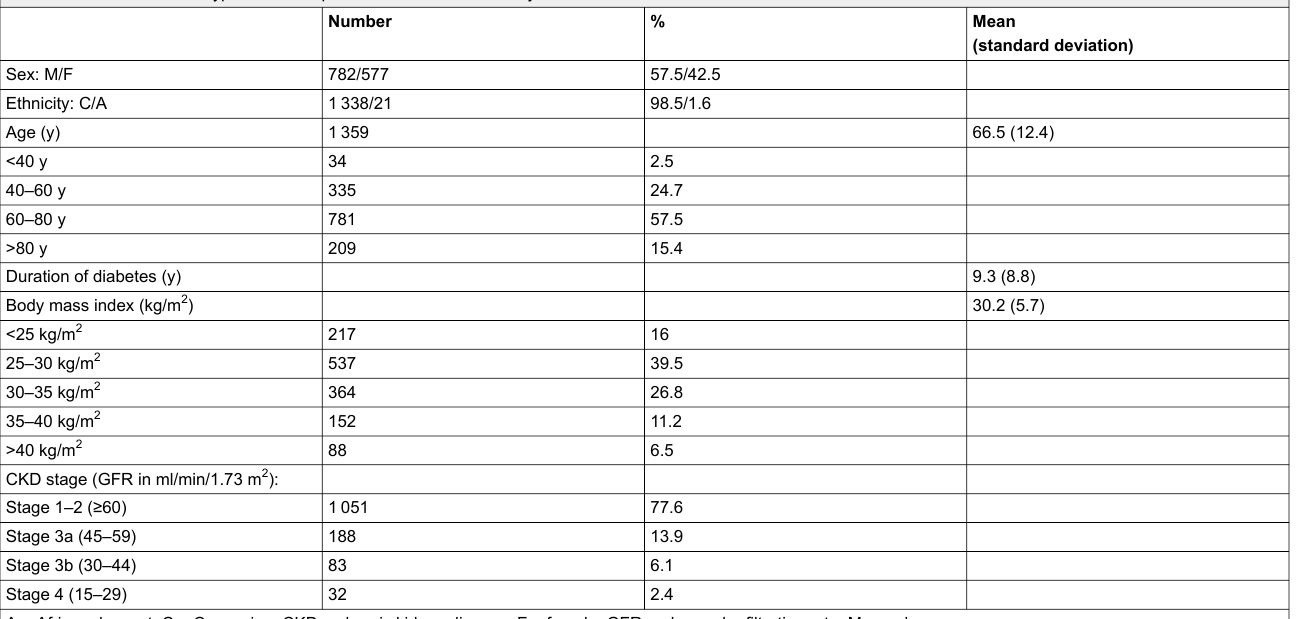
Table 2: Characteristics of type 2 diabetic patients enrolled in the study.